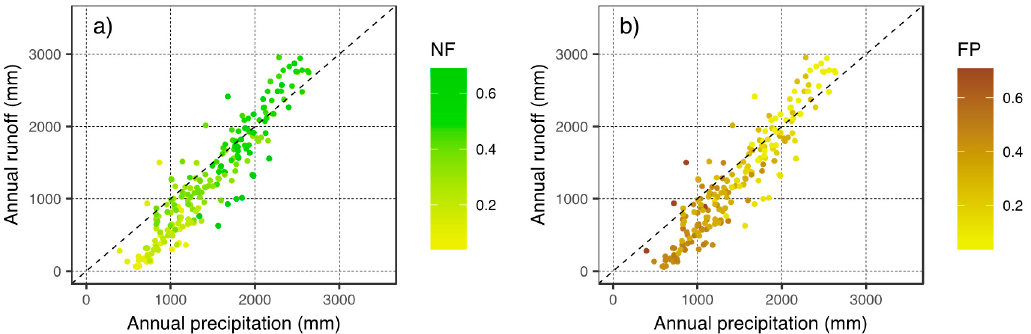
Figure 5. Scatter plots between annual runoff and annual precipitation. The plots are colored by the fraction of the catchment covered by NF (panel a ) and FP (panel b ).